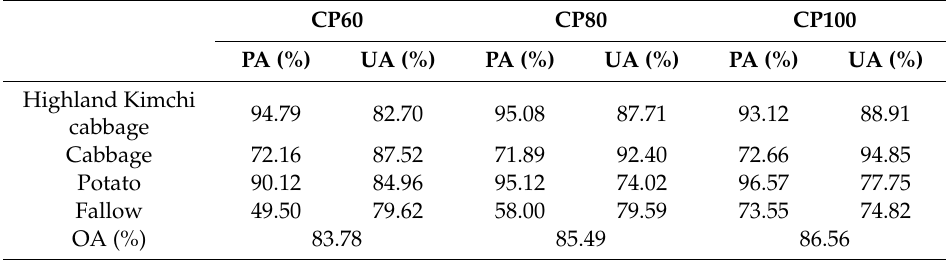
Table 5. Accuracy statistics with respect to different class purity values when using a 9 by 9 patch in Anbandegi (PA: producer’s accuracy; UA: user’s accuracy; OA: overall